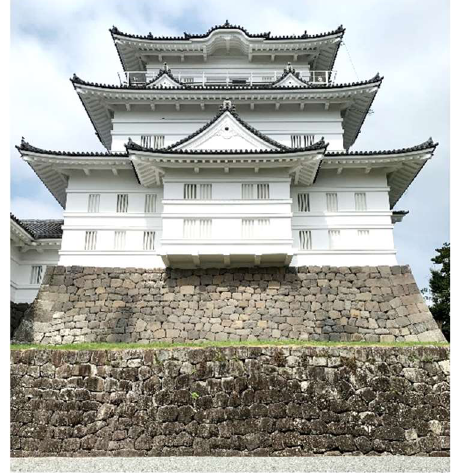
Figure 1. Example of a typical castellated